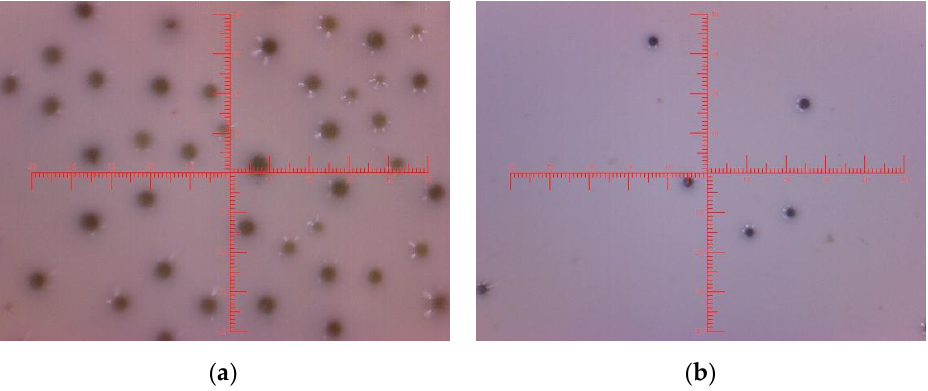
Figure 5. Appearance of coating surfaces under an optical microscope at 200× magnification ( a ) Sr. No. 1; ( b ) Sr. No. 2. ( a ) Sr. No. 1; ( b ) Sr. No.